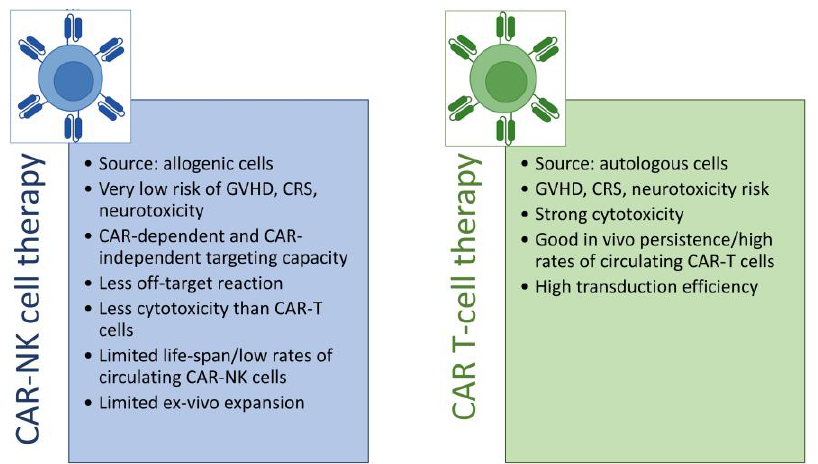
Figure 3. Summary of CAR-NK cell therapy features (list on the left) and CAR-T cell therapy features (list on the right).